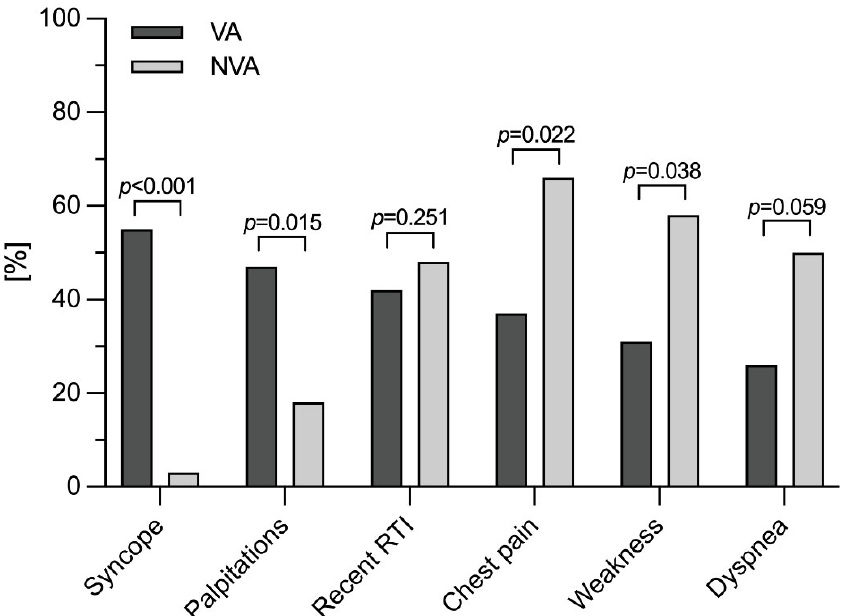
Figure 1. Clinical symptoms differ between VA vs. NVA patients. Symptoms at initial admission are presented for VA vs. NVA patients. NVA, non-ventricular arrhythmia; RTI, respiratory tract infection; VA, ventricular arrhythmia.